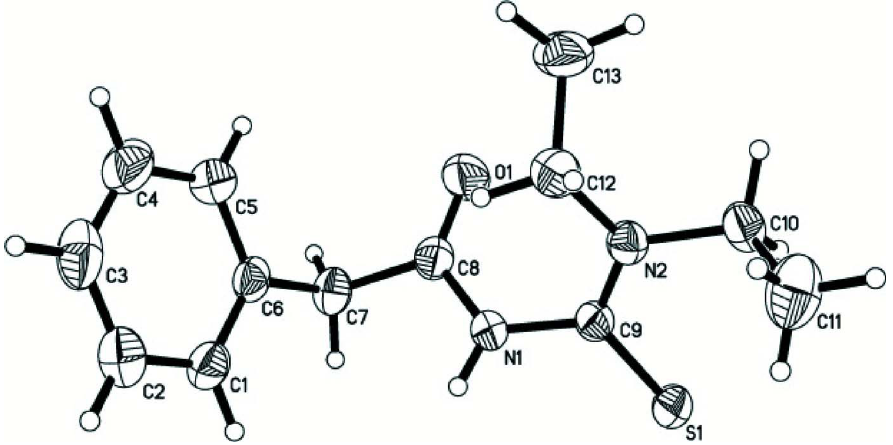
The molecular structure of the title compound. Displacement ellipsoids are drawn at the 40% probability